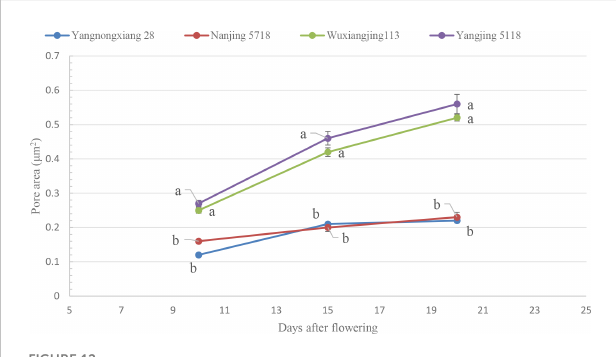
FIGURE 12 Dynamic variations of pore areas of individual starch grains of different soft rice varieties during the fi lling period. For each column, values not displaying the same letter are signi fi cantly different (p <